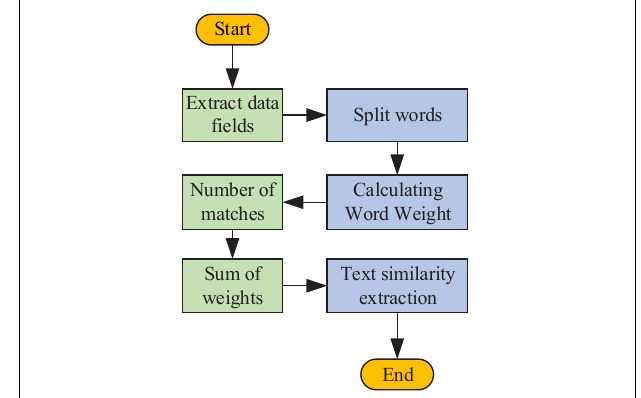
FIGURE 9 | Calculation flowchart of similarity.